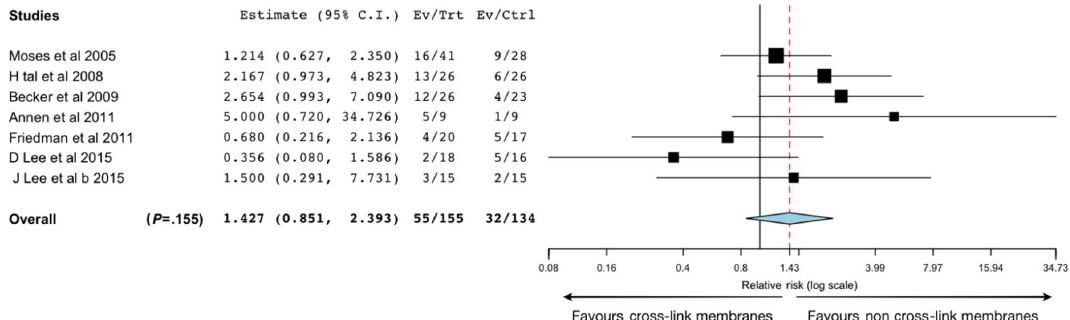
Figure 3. Analysis and forest plot for the results of the included studies that determined membrane exposure. Ev/Trt represents the test (cross-linked membranes) group, while Ev/Ctrl represents the control (non-cross-linked membranes) group. Red line represents the average for all results, and the vertical black line represents the no-effect line (from Garcia J, et al. Effect of cross-linked vs non-cross- linked collagen membranes on bone: A systematic review. J Periodontal Res . 2017;52(6):955–964. With permission)